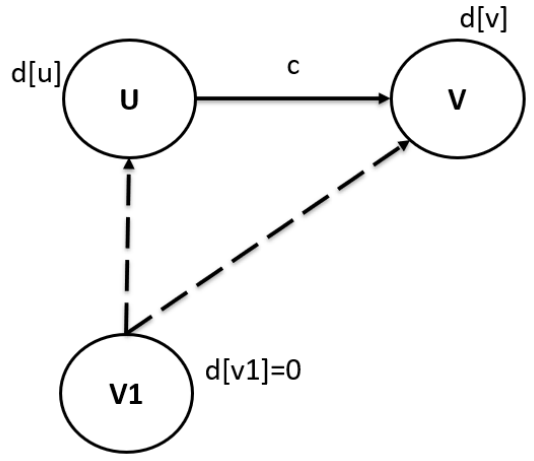
Figure 6. Graphical representation of the relaxation operation .